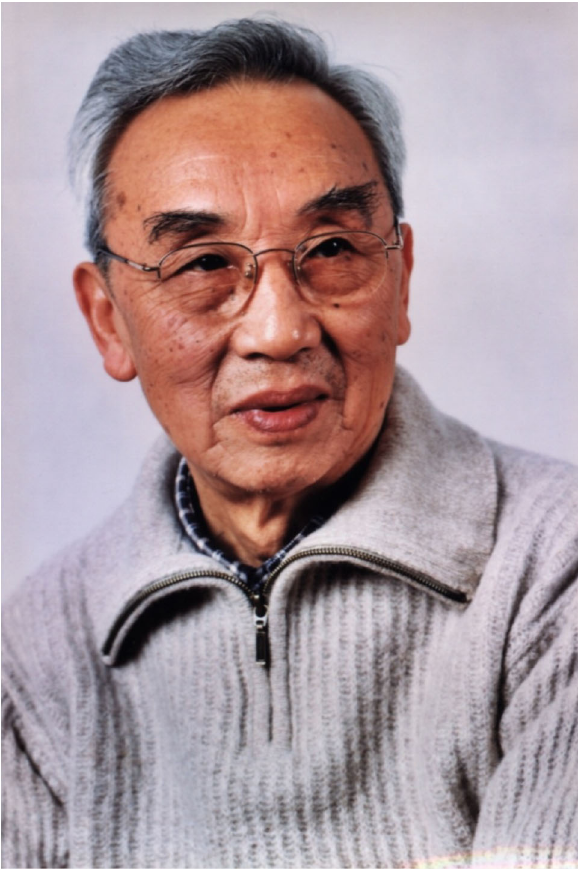
Figure 1. Prof. Jilun Li.